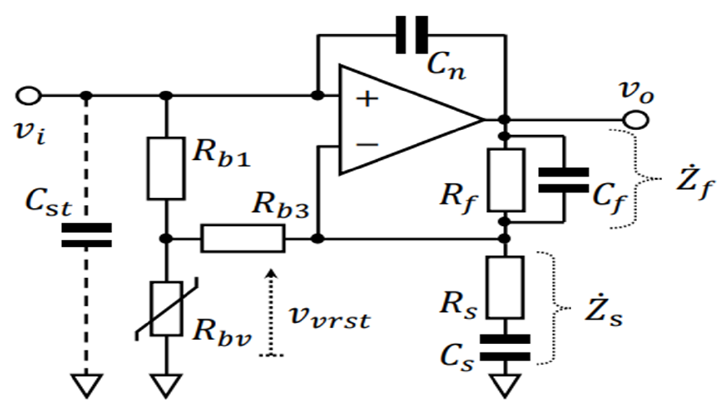
Figure 10. Proposed AFE (BNArf) [122] (Reproduced with permission from [122], MDPI, 2020).